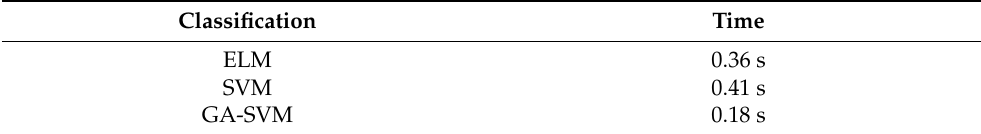
Table 4. Fault diagnosis times of different classification